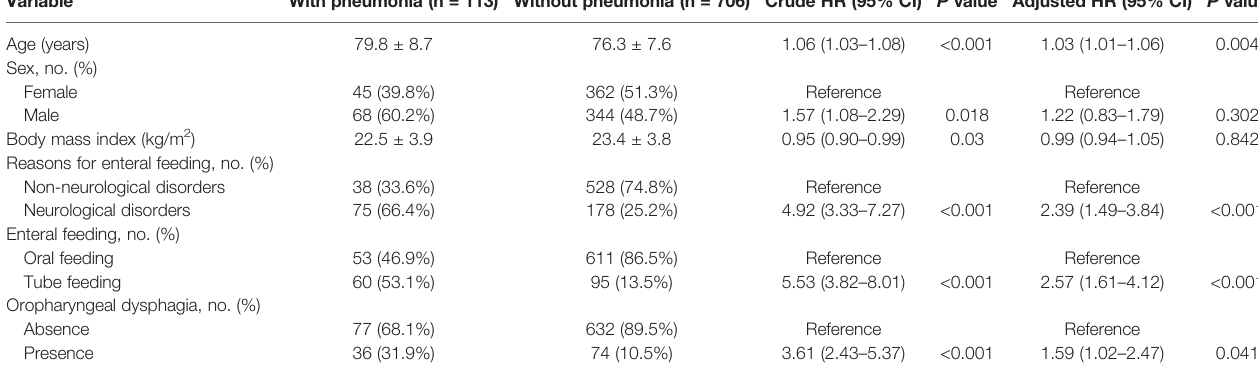
TABLE 2 | Multivariable analysis of the factors associated with pneumonia.